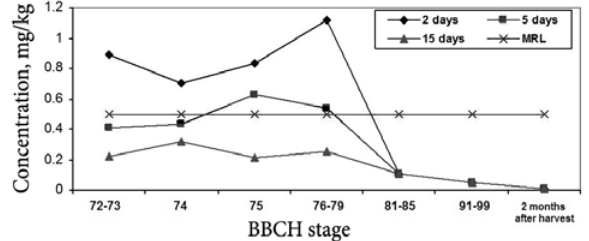
Fig. 13. Degradation of chlorpyrifos-methyl in Jonathan apples